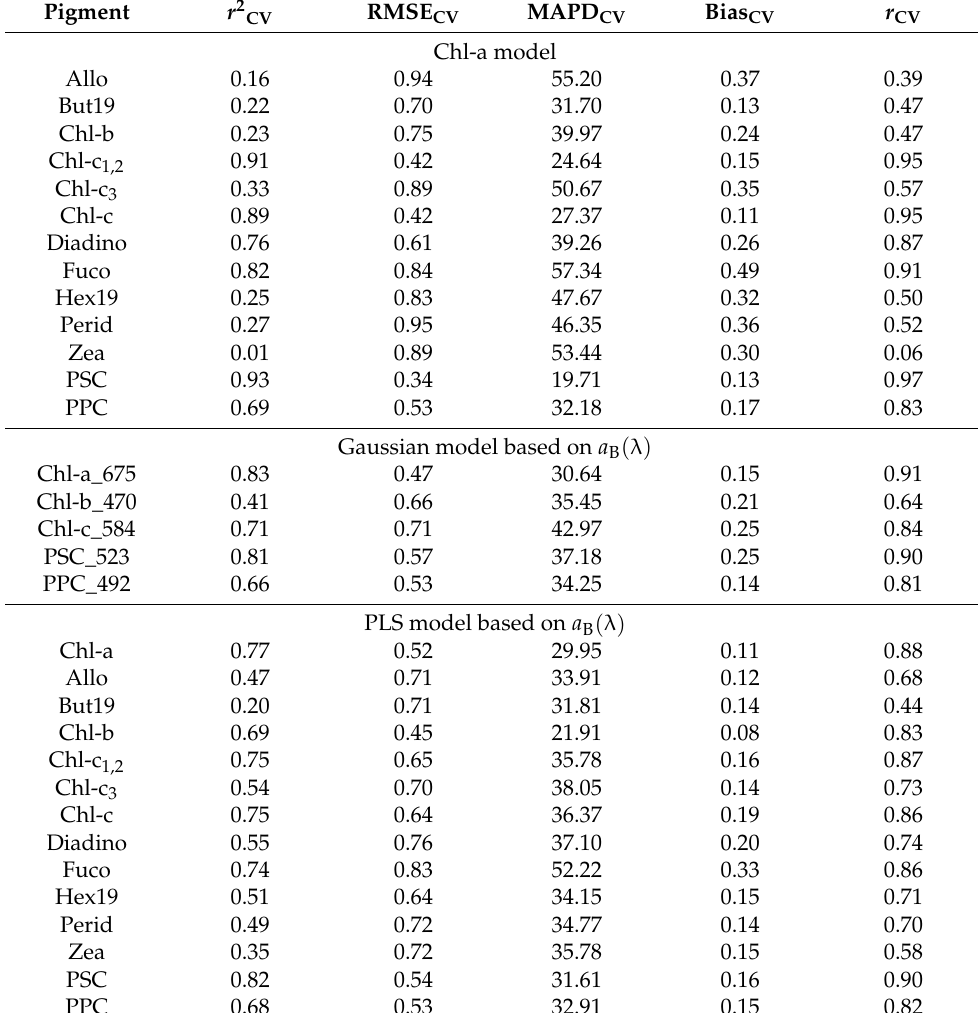
Table 7. Mean statistics of the CV of 500 permutations based on S_train and S_test for the three model types, i.e., the Chl-a model, Gaussian model, and PLS model based on hyper a B ( λ ). For the Gaussian model, the optimum performance for each pigment was chosen for presentation